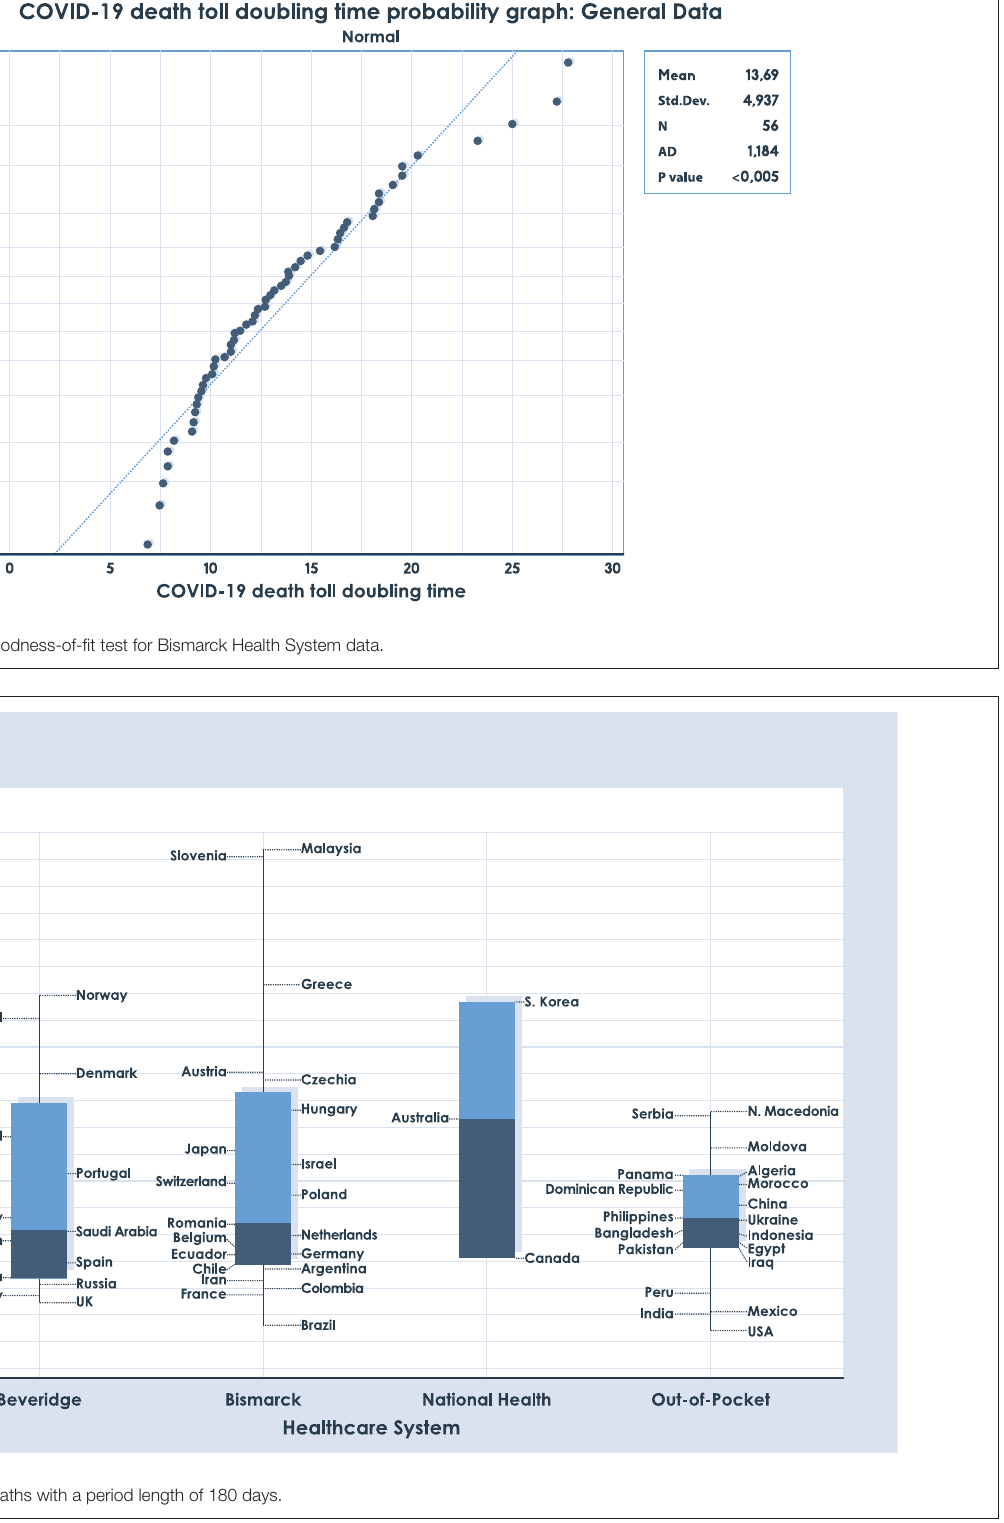
Mood’s median test confirms with a p -value of 0.05 that the four NHSs do not have statistical differences of the